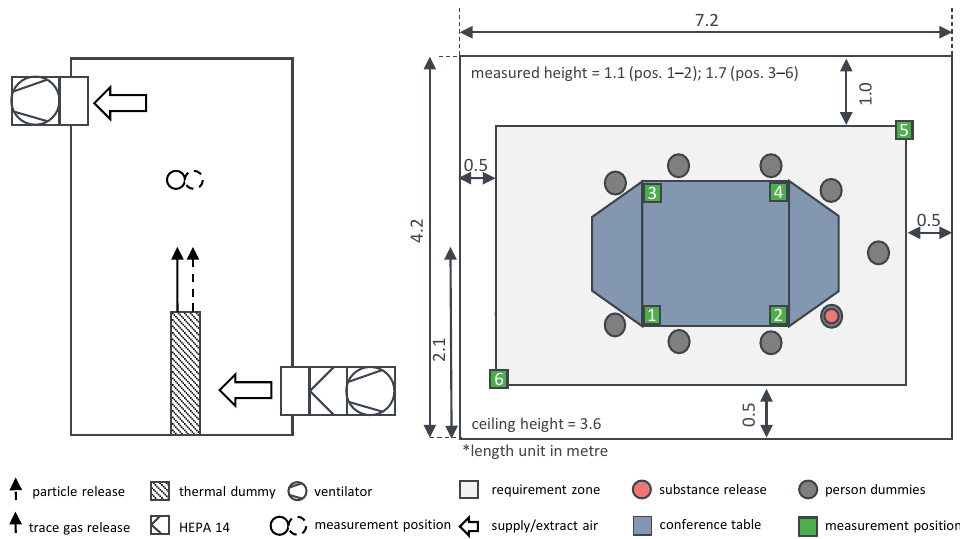
Figure 1. Set up to compare the two methods ( left ) and top view of the conference room ( right ).